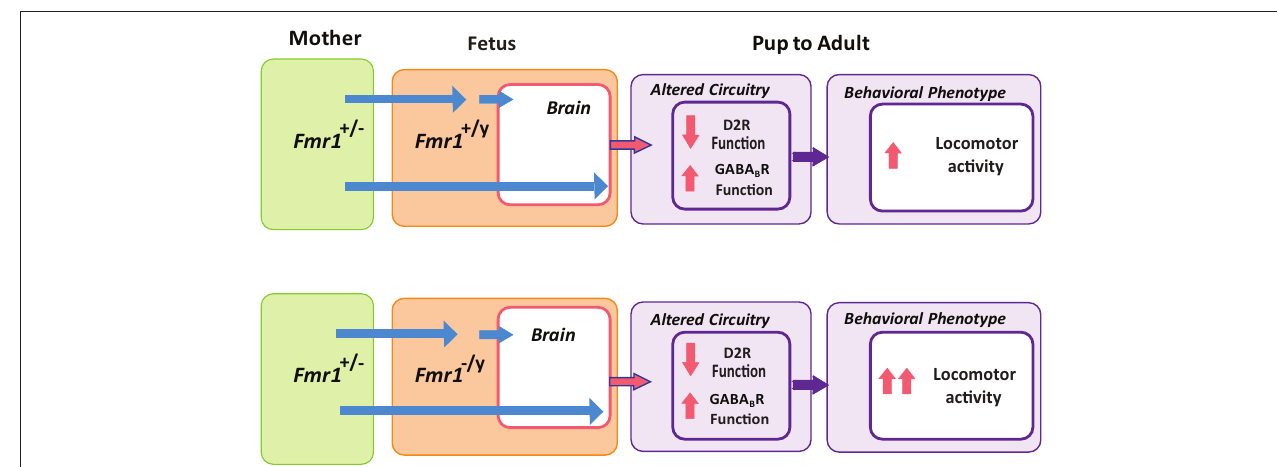
Figure 4 | Maternal and offspring fmr1 genotype effects on locomotor activity. Locomotor activity is increased in genetically unaffected animals due to maternal FMRP deficit, and this behavioral effect is further enhanced by the offspring’s own lack of FMRP. Maternal FMRP deficit increases GABA